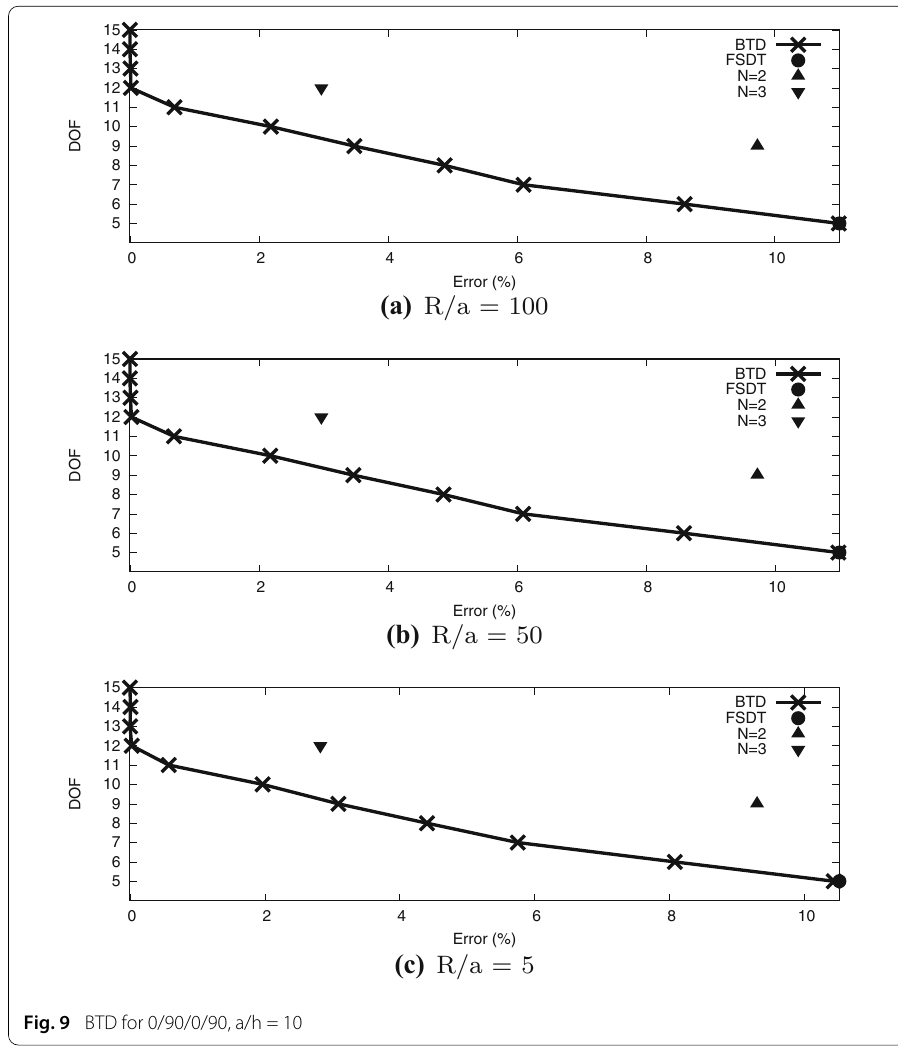
Fig. 9 BTD for 0/90/0/90, a/h =